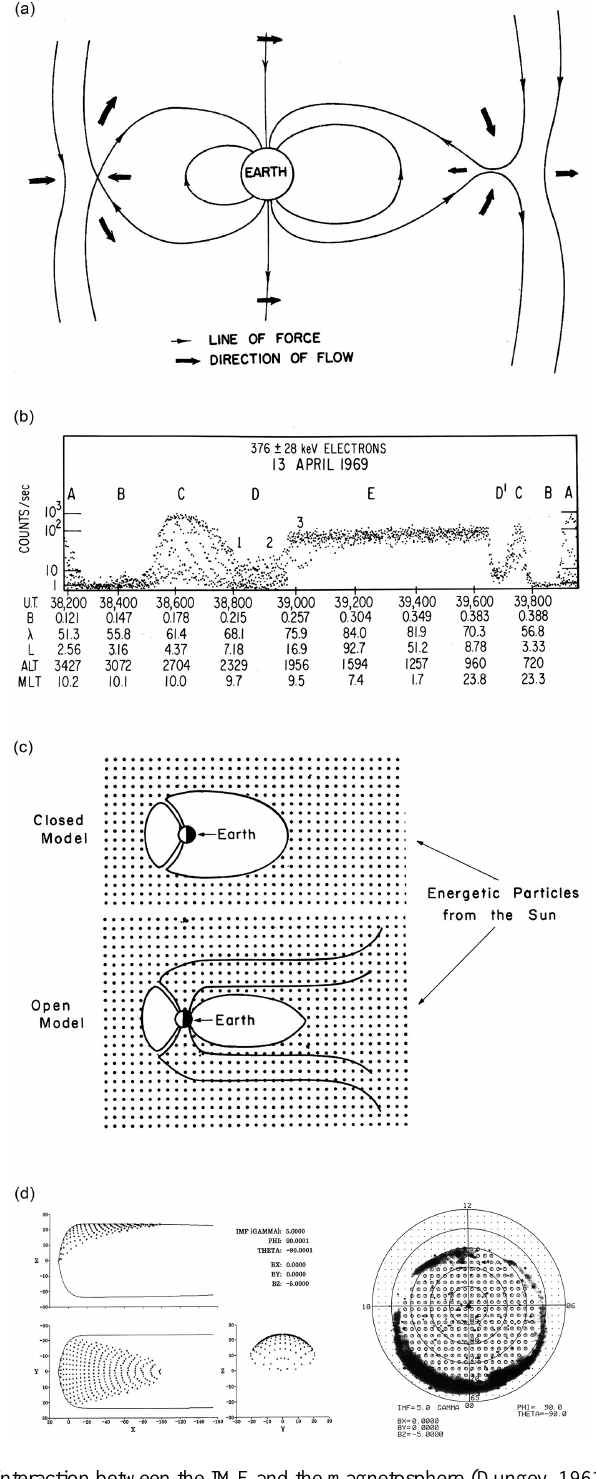
Figure 3. (a) Dungey’s idea of the interaction between the IMF and the magnetosphere (Dungey, 1961). (b) Observation to show that high energy electrons penetrate in the auroral oval uniformly. Note the latitude ( λ ) where the uniform flux drops in the morning side and the night side (MLT). The lower latitude fluxes are the Van Allen belt electrons (Vampola., 1971). (c) Schematic figure to illustrate the difference of the closed and open magnetospheres, when solar energetic electrons reach the earth. (d) Left: the entry points of the merged field lines on the magnetopause based on a model. Right: the root of the merged field lines in the polar region is surrounded by the auroral oval.